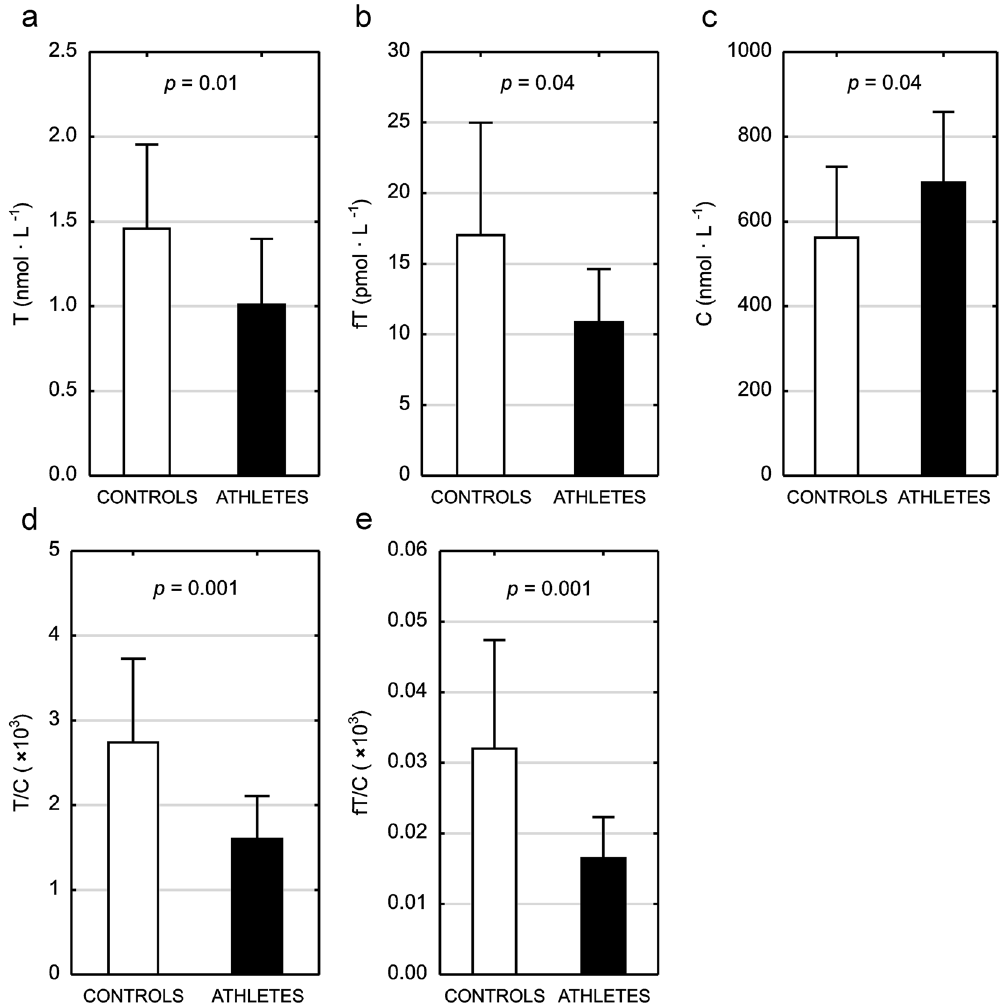
Figure 1. Androgen status in female athletes and age-matched control group. Testosterone (T—panel a ); free testosterone (fT—panel b ); cortisol (C—panel c ); testosterone to cortisol ratio (T/C—panel d ); free testosterone to cortisol ratio (fT/C—panel e